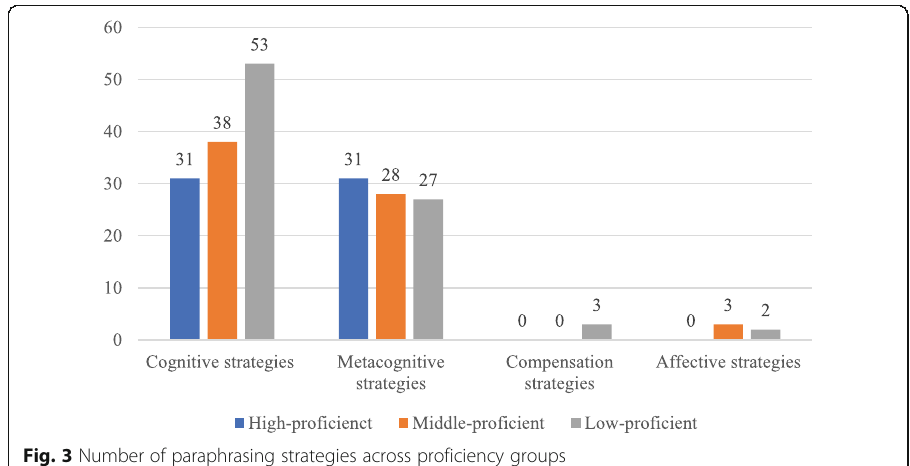
Fig. 3 Number of paraphrasing strategies across proficiency groups